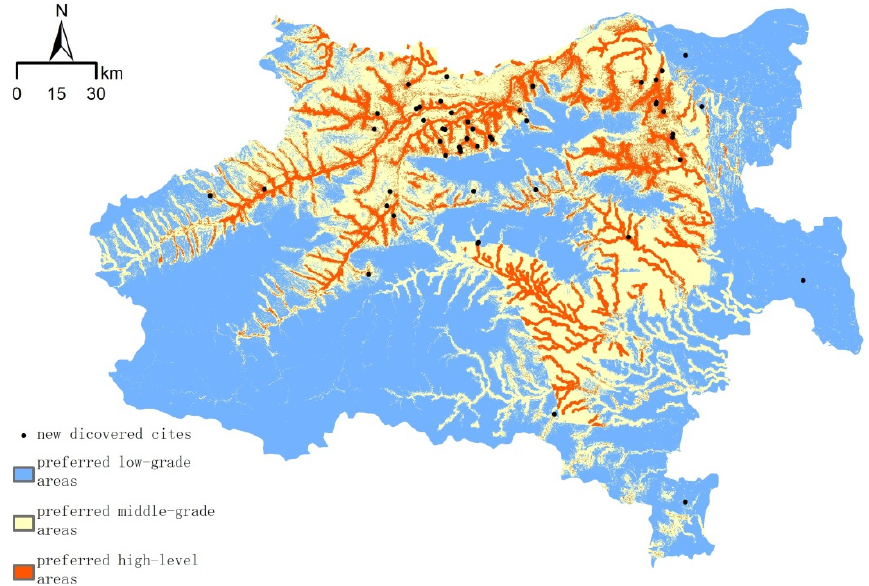
Figure 3. Overlay map of the comprehensive zoning of settlement site selection model in Yangshao period Songshan, and new discovered sites.